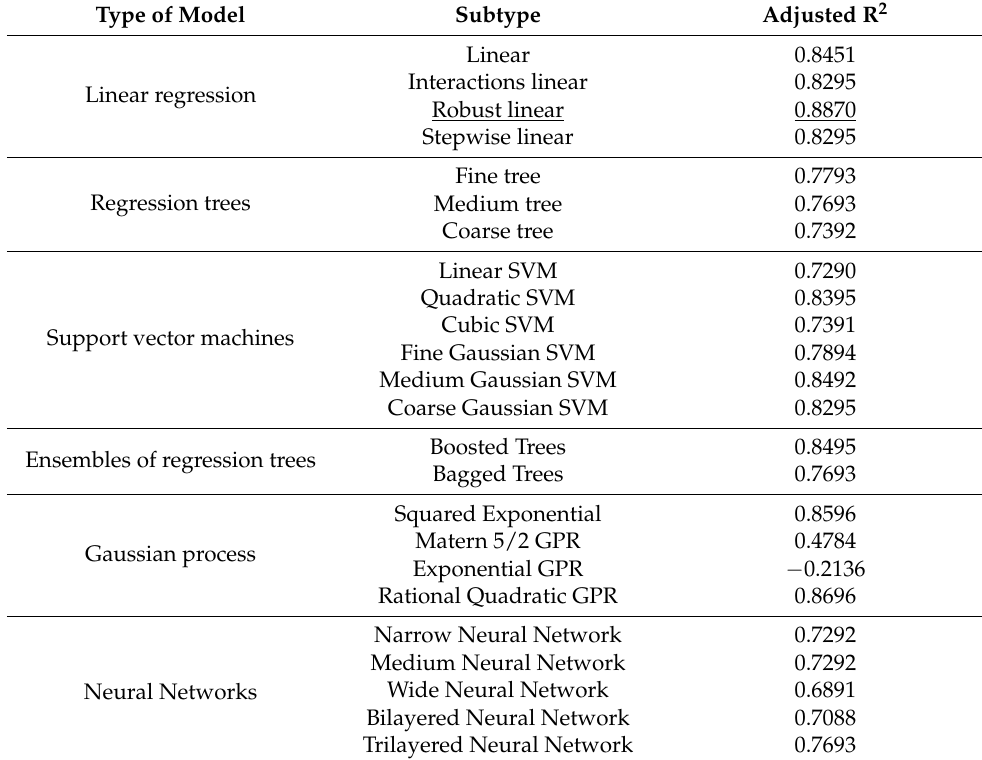
Table 9. Results from regression models testing, with the whole second-hand tractor